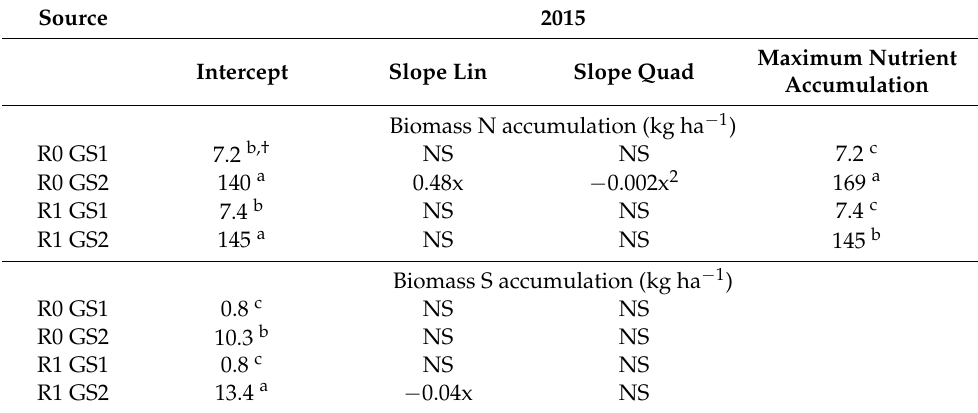
Table 4. Biomass N and S accumulation in 2015 as a function of N rates, residue management, and growth